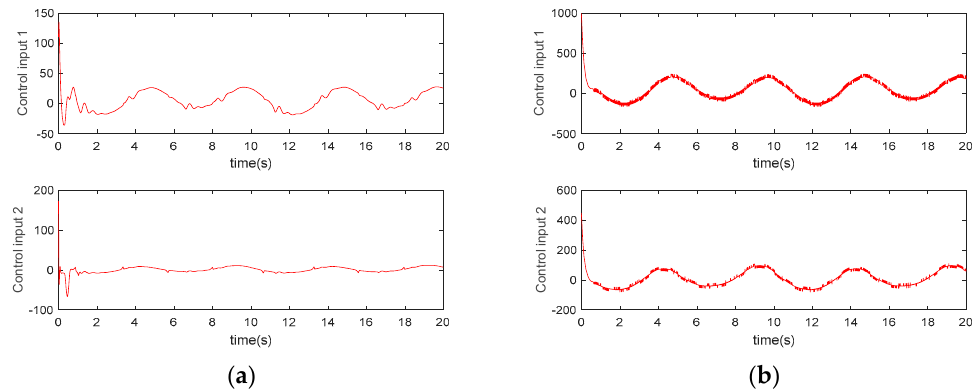
Figure 10. ( a ) Control inputs of robust adaptive sliding mode control (RASMC); ( b ) Control inputs of sliding mode control (SMC).